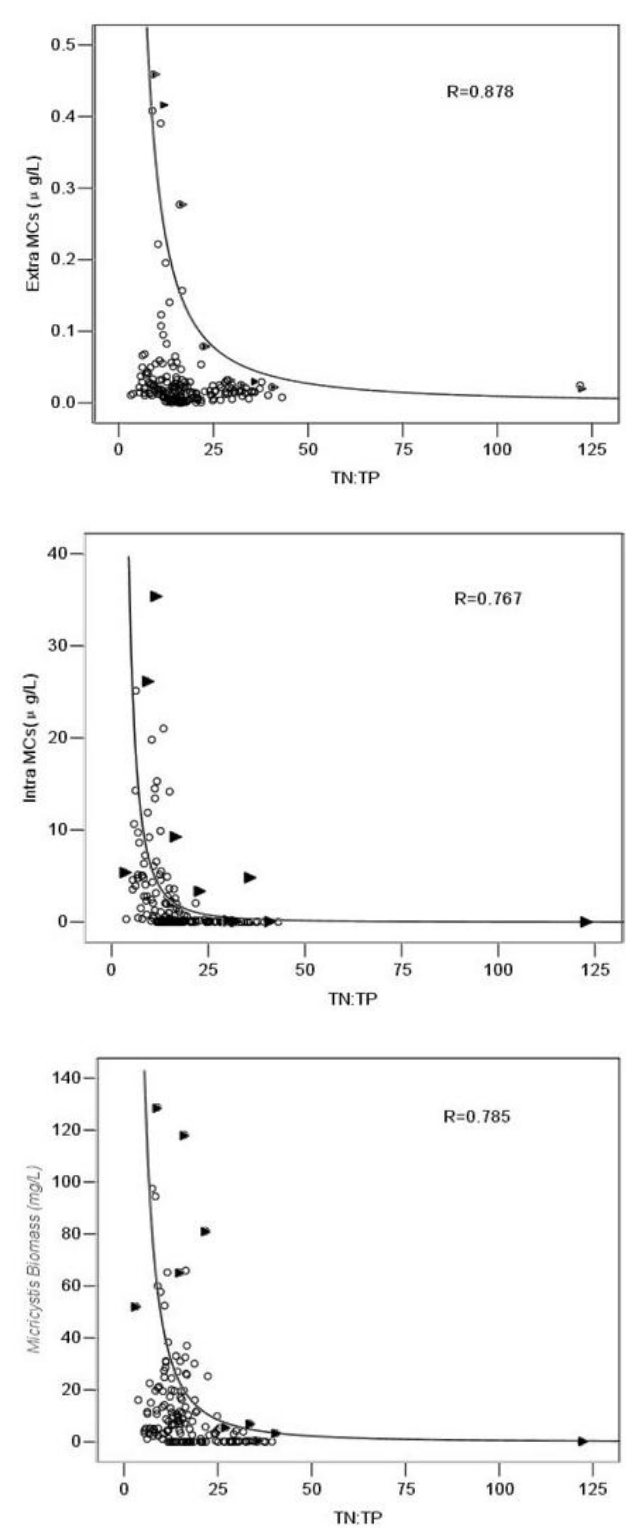
FIGURE 10 . Relationships between TN:TP ratio and intra- or extracellular MC concentration or Microcystis biomass. Curves were estimated using